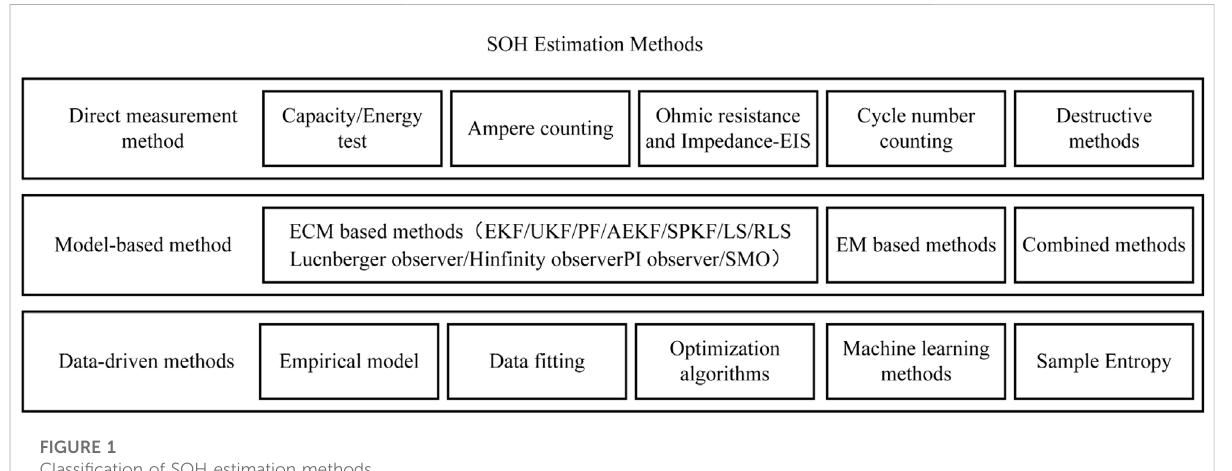
FIGURE 1 Classi fi cation of SOH estimation